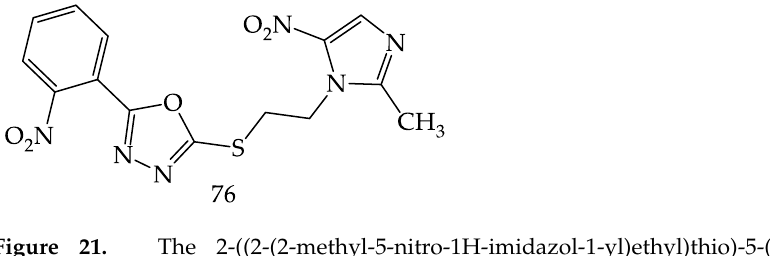
Figure 21. The 2-((2-(2-methyl-5-nitro-1H-imidazol-1-yl)ethyl)thio)-5-(2-nitrophenyl)-1,3,4-oxadiazoleas thymidylate synthase inhibitor .